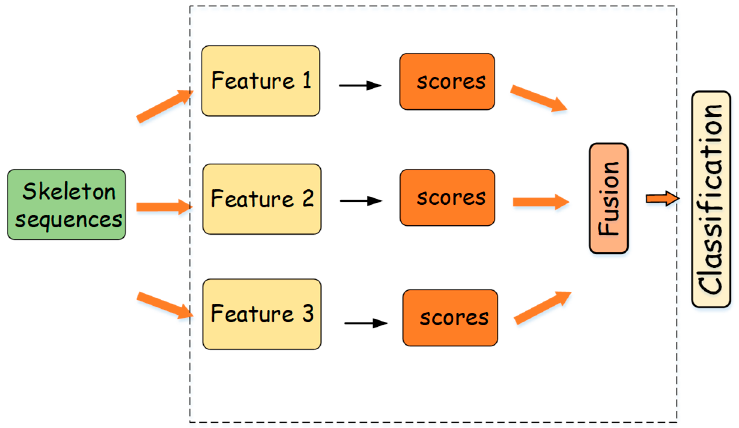
Figure 5. Ensemble network framework.